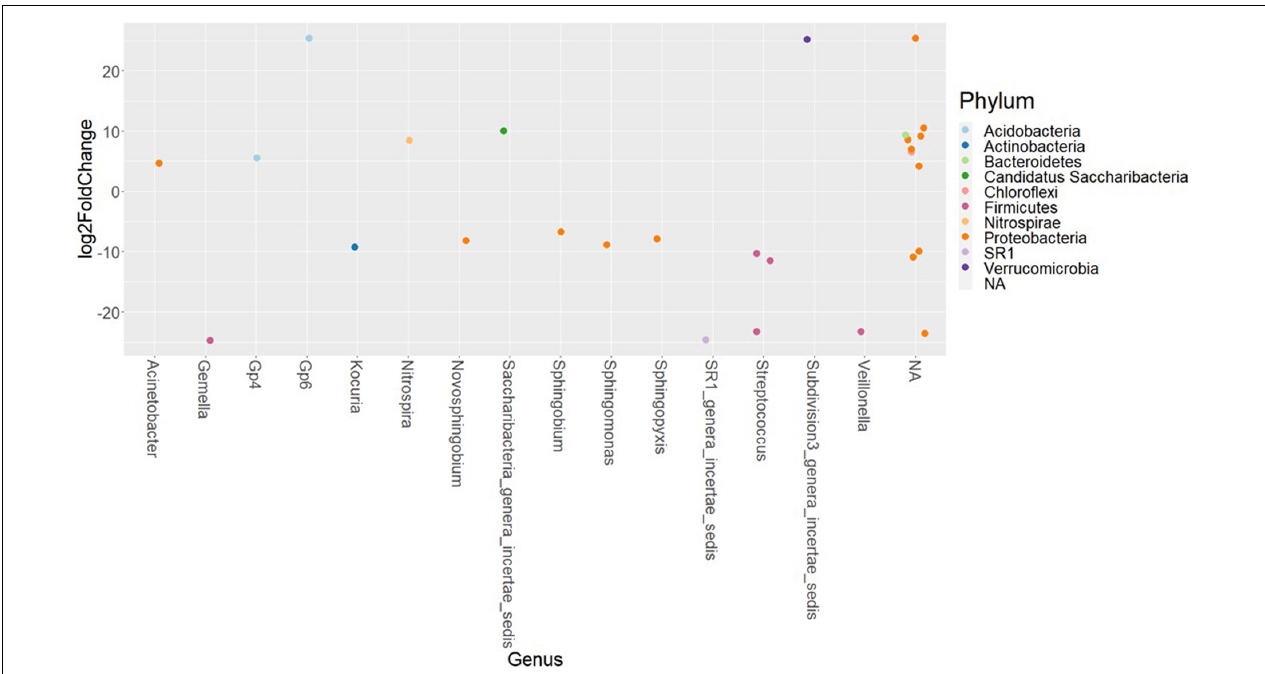
FIGURE 4 | The significantly abundant amplicon sequence variants in the buccal cavity of female Nile tilapia compared to males. The X -axis labels are genus-level annotations of the microbes identified in the buccal